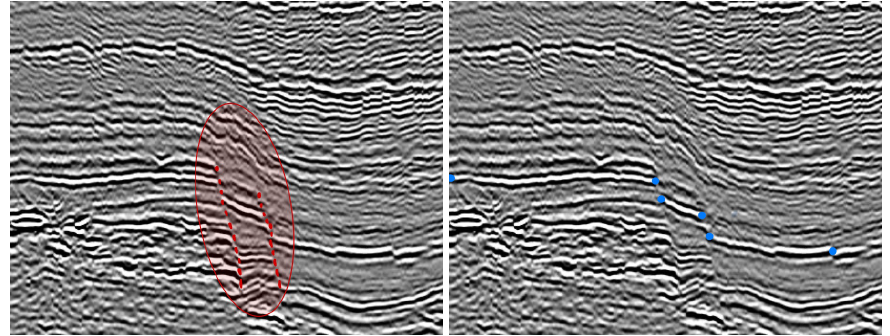
Figure 12. Left : The red zone underlines the vertical fault (with dotted segments). Right : As a geometric conditions, we consider a set of points given by the user.